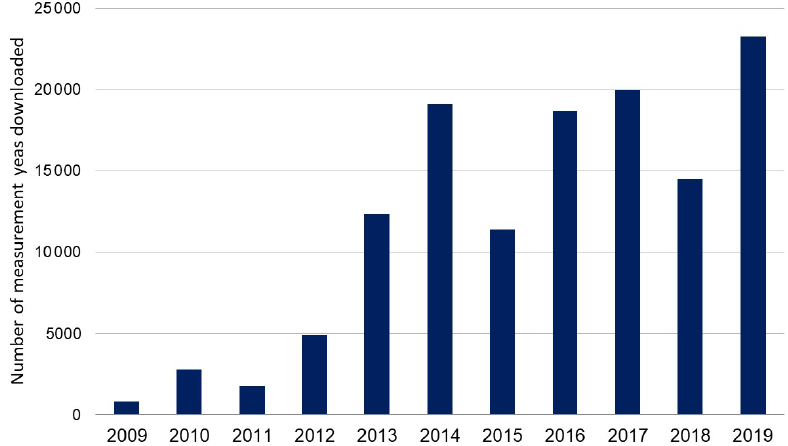
Figure 4. The use of SARGAN data from GAW-WDCA over the period May 2009–October 2019 as indicated by the number of full years of measurement data downloaded each year. Data extracts as tailored special delivery (the full database for a special purpose) are not